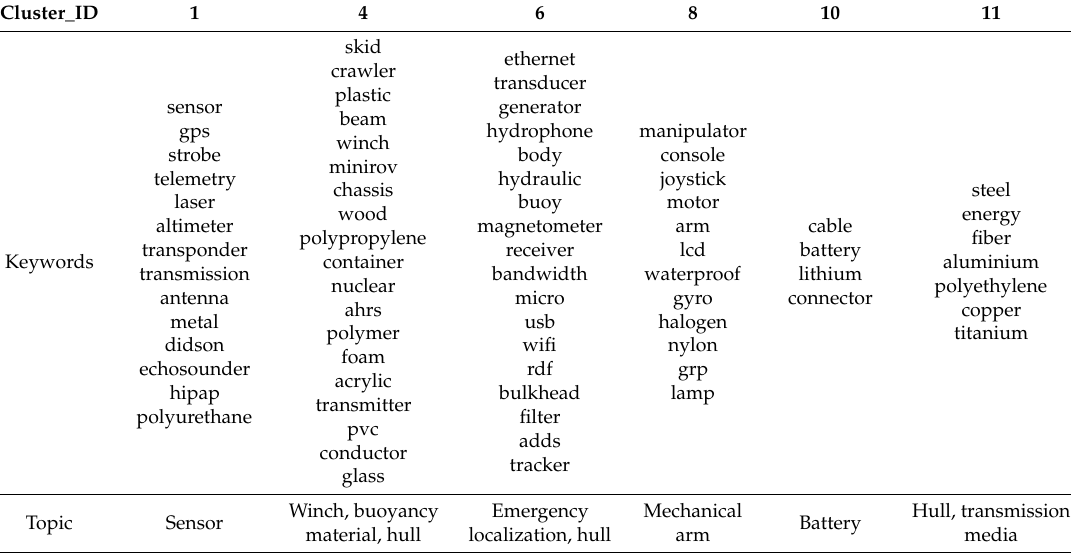
Table 3. An example of K-means clustering result of product